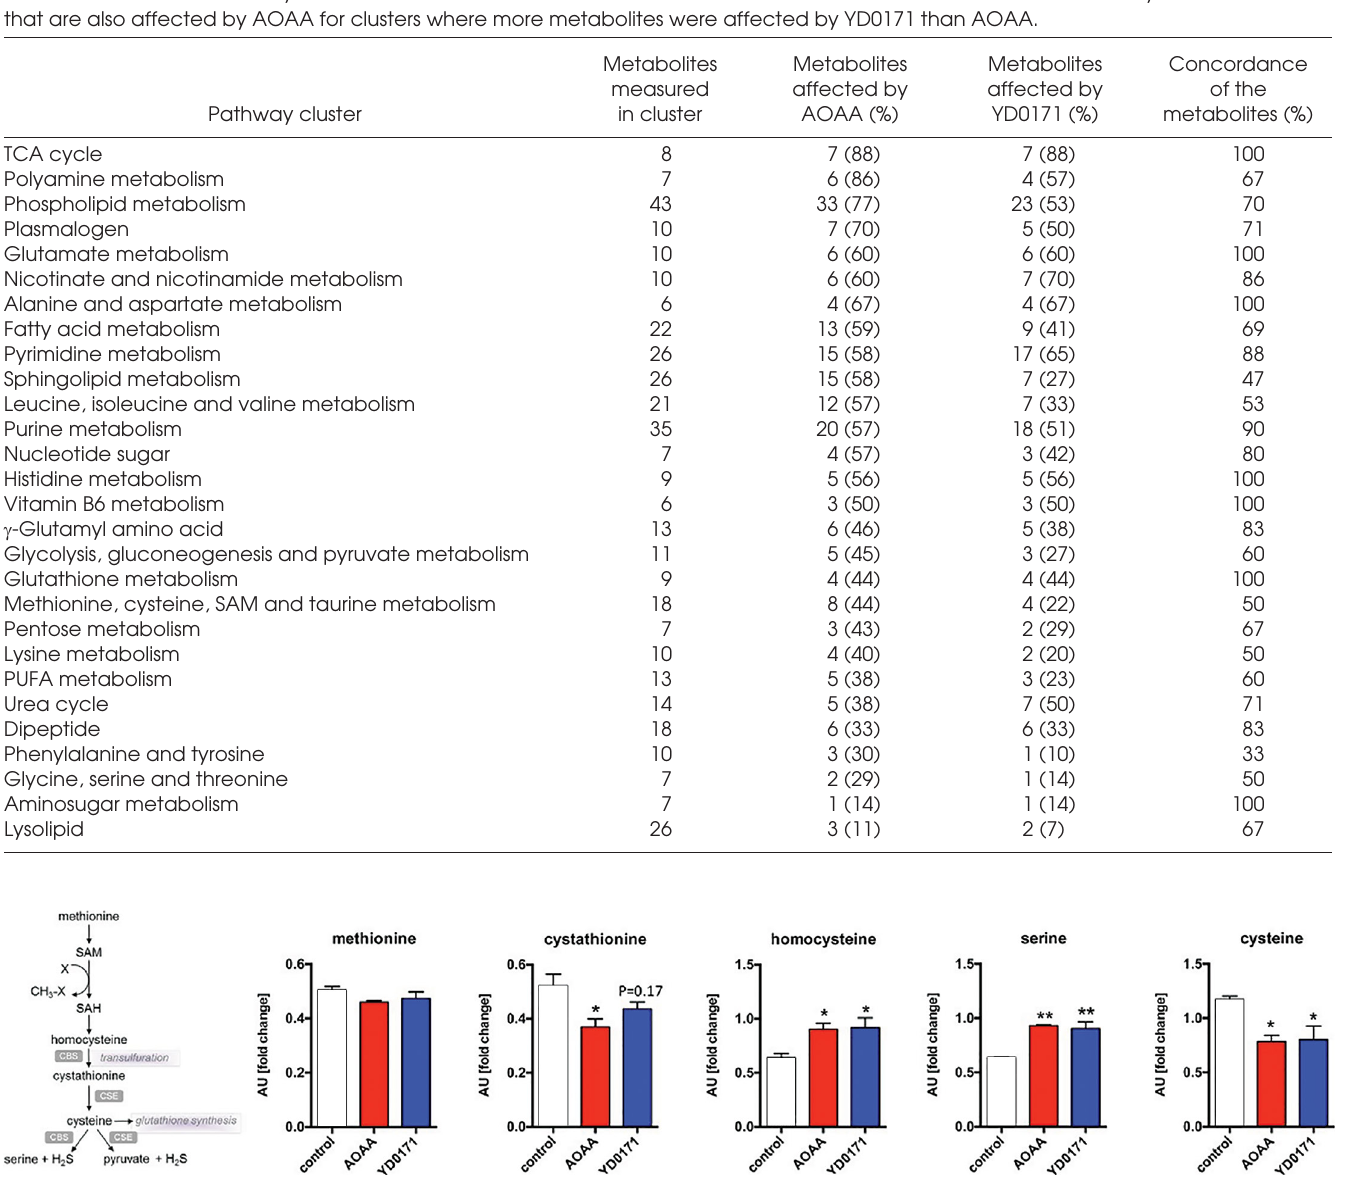
Table 3. Metabolomic effects of AOAA and YD0171: enrichment analysis. Clusters with >5 measured metabolites are presented. Concordance is calculated as the % of metabolites affected by AOAA that are also affected by YD0171 for clusters where more metabolites were affected by AOAA than YD0171 and concordance is calculated as the % of metabolites affected by YD0171 that are also affected by AOAA for clusters where more metabolites were affected by YD0171 than AOAA.